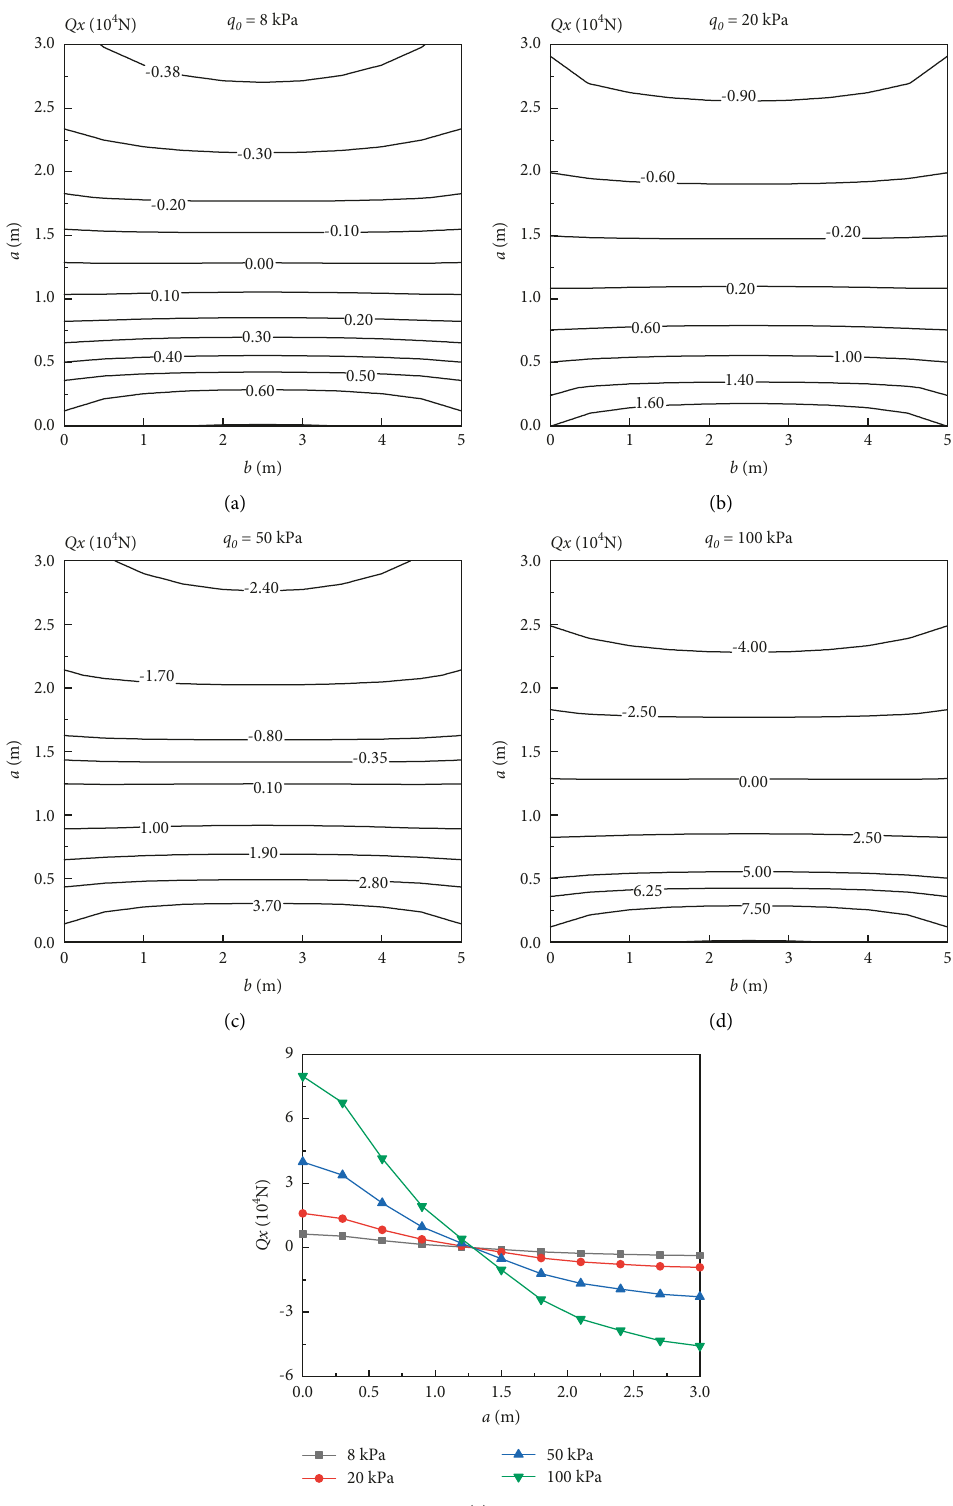
Figure 10: Effect of frost heaving force on shear force Q